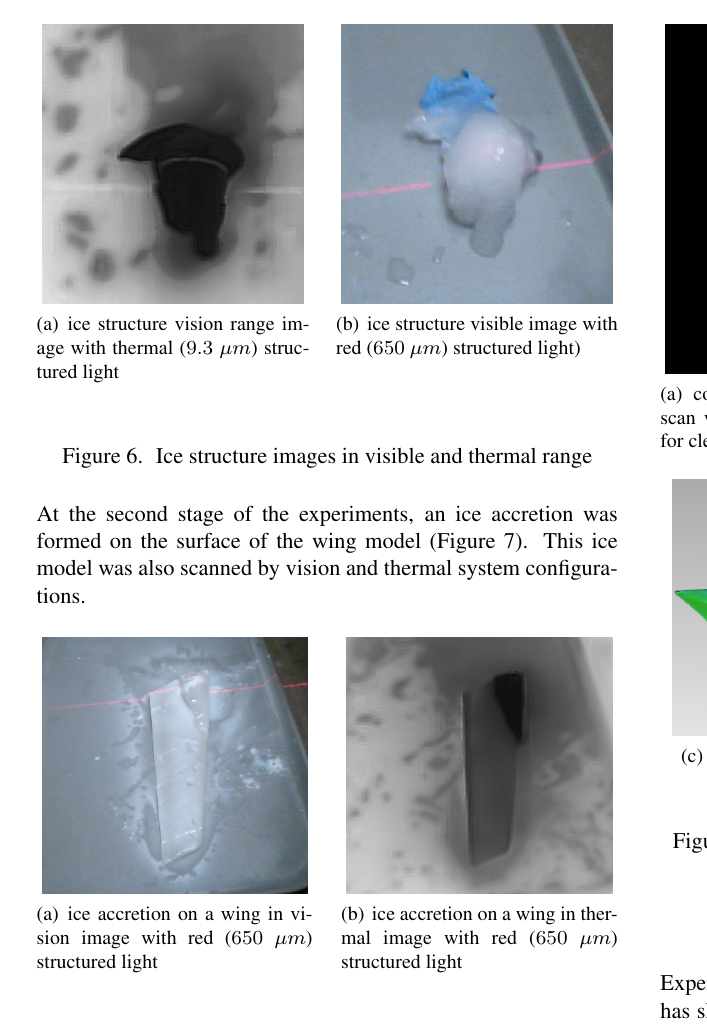
Figure 7. Ice accretion on wing SLA model in visible and thermal range